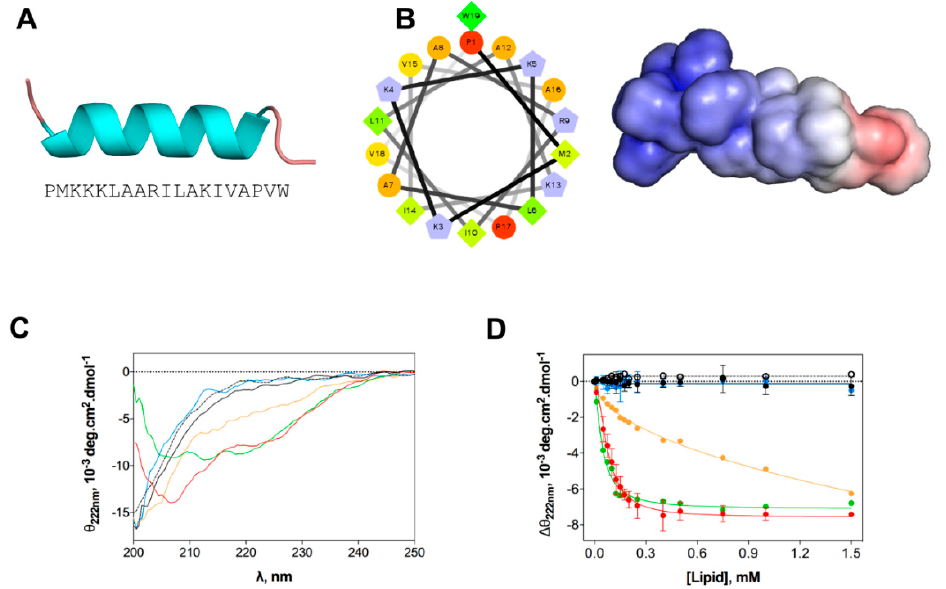
Figure 2. In silico and experimental structural studies of EcDBS1R4 structure. ( A ) Amino acid sequence of EcDBS1R4 and theoretical three-dimensional structure predicted by homology and constructed using Modeller v. 9.12. ( B ) α -helical wheel (constructed using the server http://rzlab.ucr.edu/scripts/wheel/wheel.cgi; hydrophobic residues are represented as green diamonds, hydrophilic, non-charged residues are coded as orange circles, and positively charged residues are blue-grey pentagons) and adaptive Poisson-Boltzmann solver electrostatic potential of EcDBS1R4, ranging from − 5.0 k B T/e (red) to +5.0 k B T/e (blue). ( C , D ) Experimental structural studies of EcDBS1R4 in the presence of different LUV compositions. ( C ) Circular dichroism spectra of EcDBS1R4 in solution (dotted black) at 16 µM, and in the presence of 500 µM of lipid vesicles of POPC (black), POPC:Chol (70:30) (blue), POPC:POPG (70:30) (red), inner (green) and outer (orange) membrane of E. coli mimetic systems. ( D ) Comparative plot of the θ signal at 222 nm (a local minimum for α -helices) at different lipid concentrations, with the same lipid composition described above. Solid lines represent fits to the experimental data using Equation (1). Each experiment was conducted in triplicate and represented as mean ± standard deviation (SD). Calculated parameters are presented in Table 2.